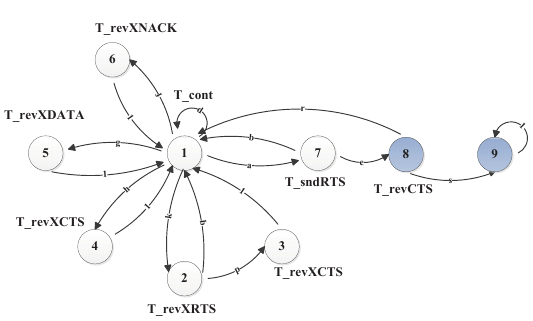
Figure 4. Absorbing Markov model for